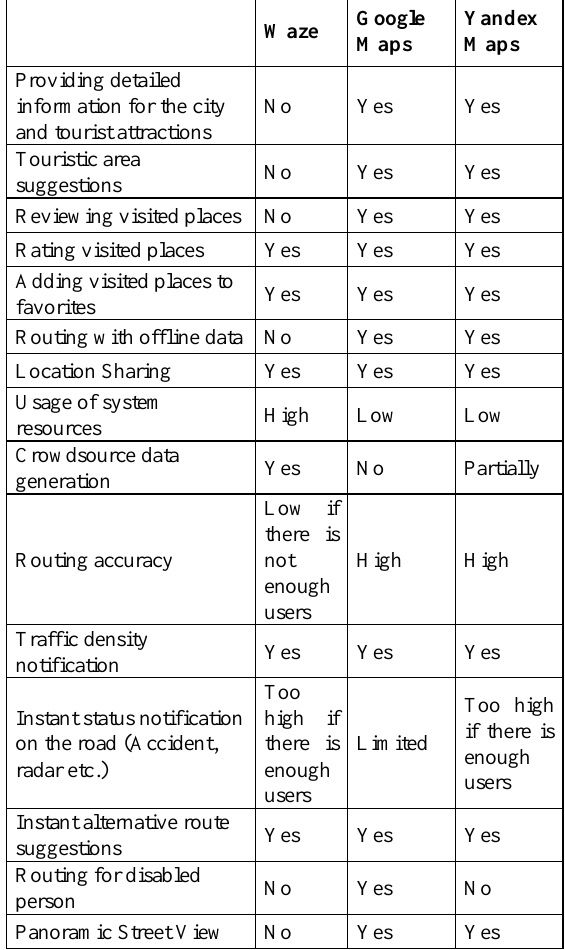
Table 1. Comparison of route planning and navigation based mobile device